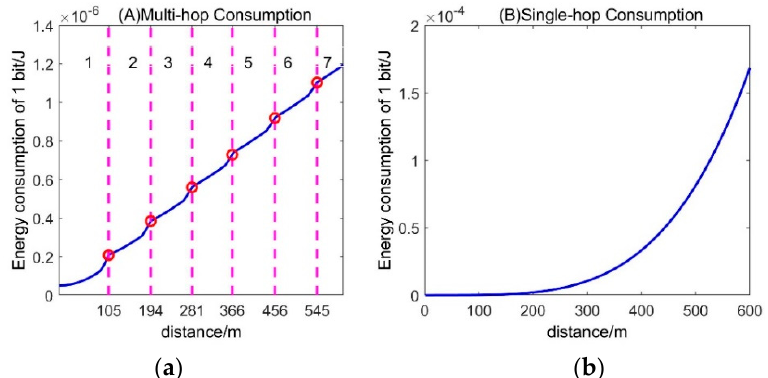
Figure 7. Minimum energy consumption and number of hops ( a ) and single hop energy consumption ( b ) for different distances.